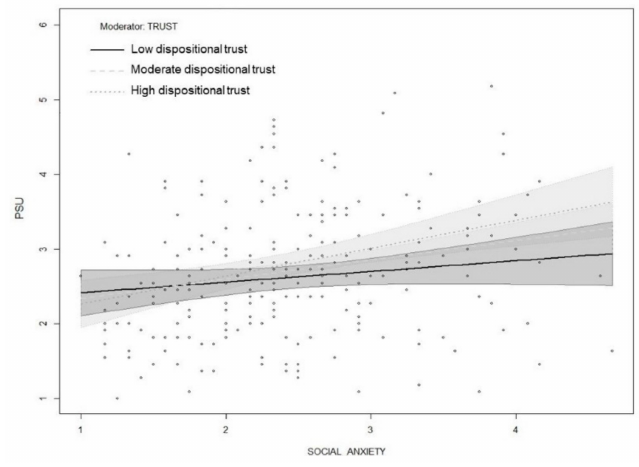
Figure 3. Interaction between social anxiety and dispositional trust on PSU.